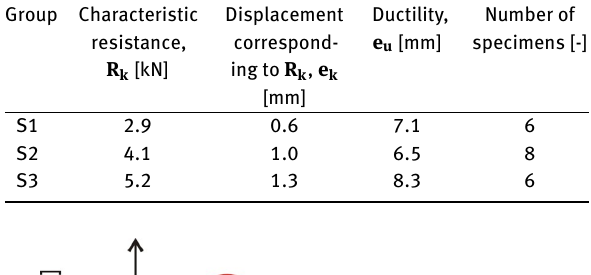
Table 3: Shear flexibility of the fastenings from monotonic test